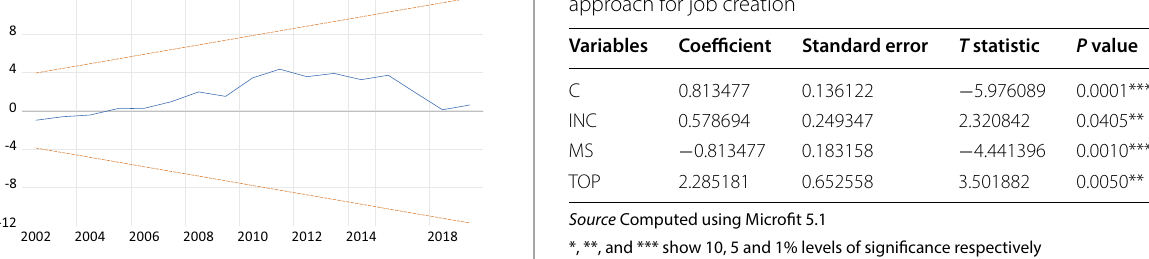
-0.40.00.40.81.21.6